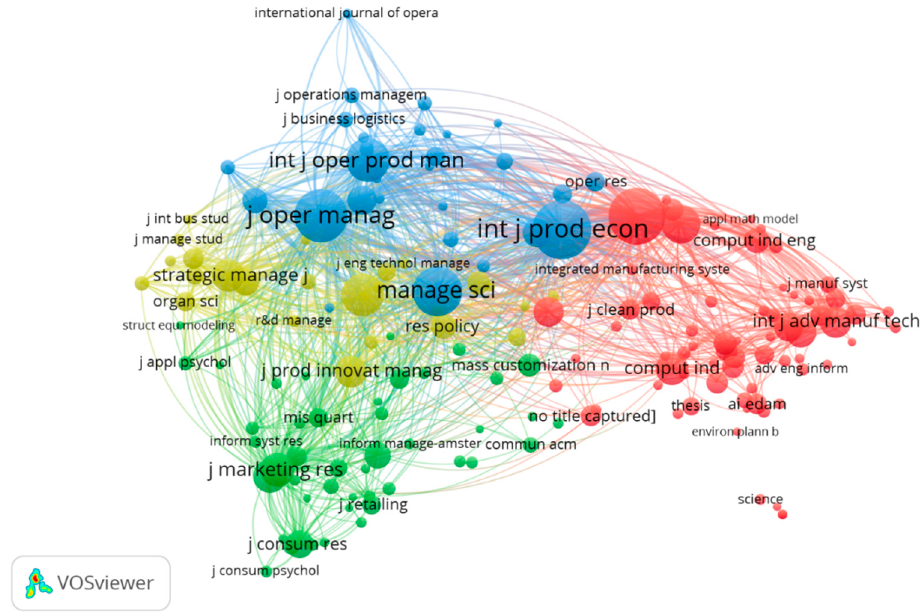
Figure 4. Co-citation of scientific journals in 1990–2020. Source: Composed by the authors using the VosViewer software.